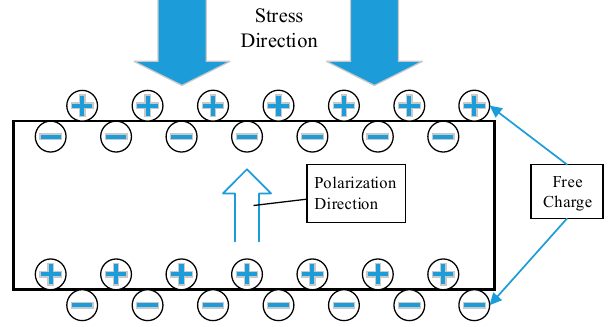
Figure 5. Schematic diagram of the piezoelectric effect.